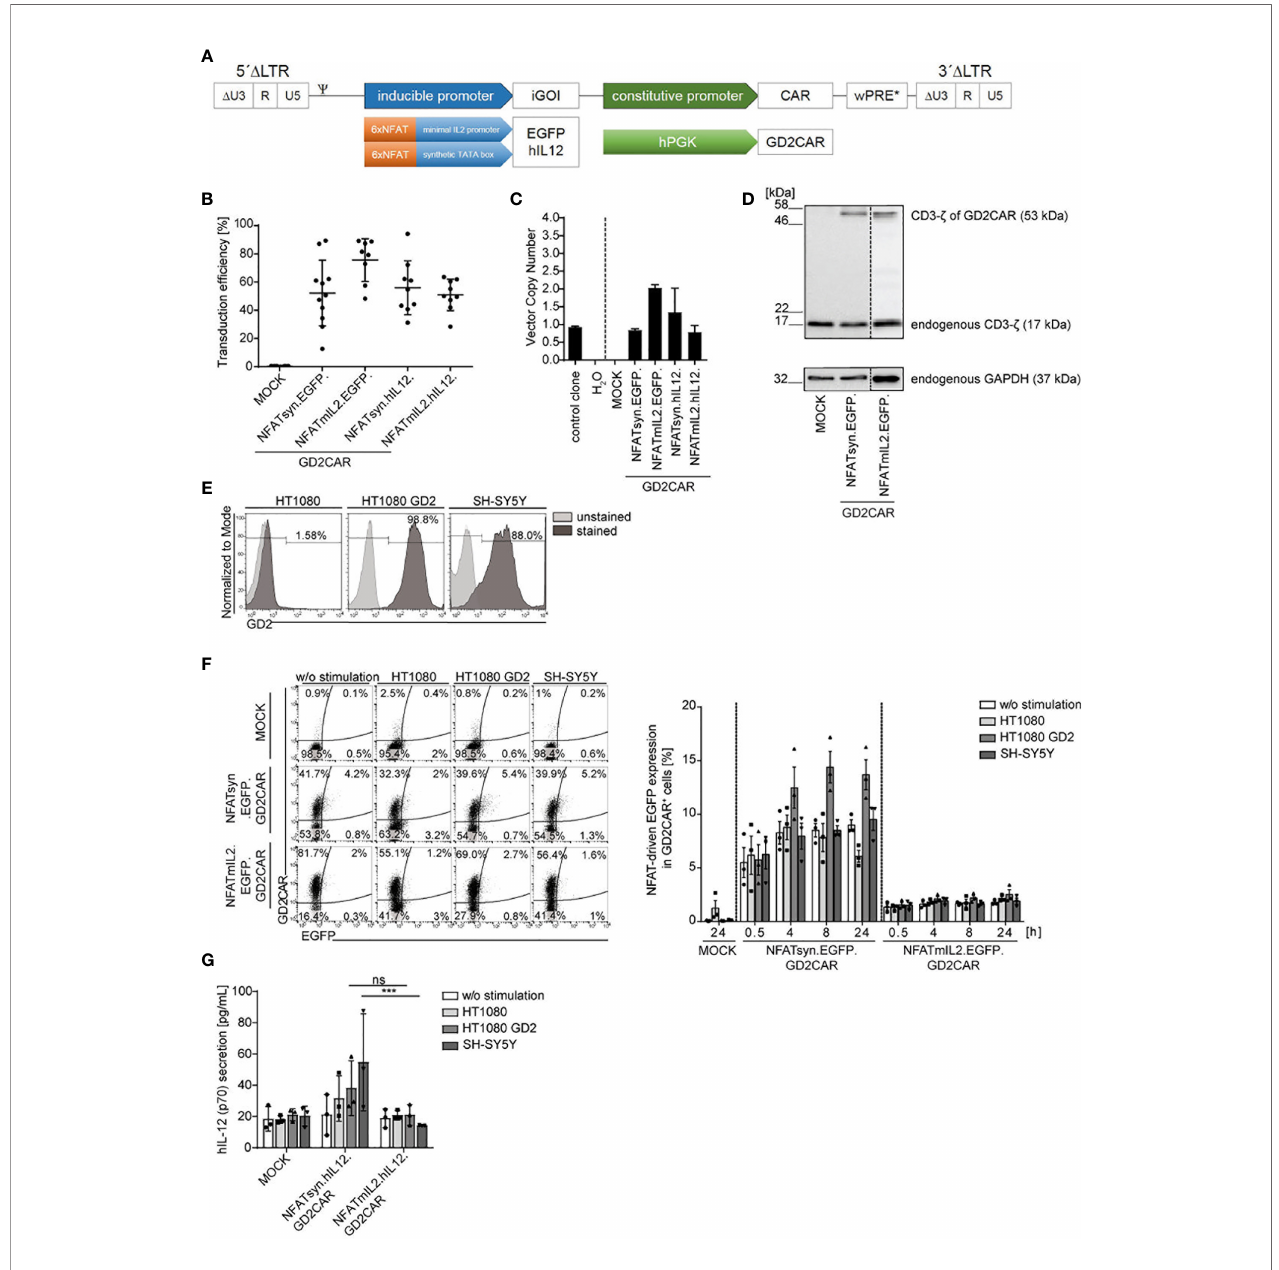
FIGURE 1 | Generation and validation of the alpharetroviral NFAT-driven “ all-in-one ” SIN vector constructs. (A) Scheme of the alpharetroviral self-inactivating “ all-in- one ” provirus constructs encoding for a constitutively expressed GD2CAR and an iGOI, namely, EGFP and hIL-12. The constitutive GD2CAR expression is driven by a human phosphoglycerate kinase (hPGK) promoter. The inducible gene cassette includes six consensus NFAT (6xNFAT) elements in combination with either a minimal IL2 promoter (NFATmIL2) or a synthetic TATA box (NFATsyn). (B) Transduction ef fi ciencies of NK-92 cells modi fi ed with the indicated alpharetroviral “ all-in-one ” SIN vector constructs and pseudotyped with RD114/TR (MOI 10). Transduction ef fi ciencies were quanti fi ed by fl ow cytometric analyses for GD2CAR expression (n = 8 – 11). (C) VCN determination of unsorted modi fi ed (MOI 10) NK-92 cells. As controls, the VCNs of a water sample and an induced pluripotent stem cell (iPSC) clone HD2 (47) with a known VCN of 1 were calculated. Technical triplicates are shown. (D) CAR protein expression in unsorted transduced (MOI 10) NK-92 cells exemplarily shown for NFATmIL2.EGFP and NFATsyn.EGFP constructs via Western blot analysis. The CD3- z domain of the GD2CAR (expected size approximately 53 kDa) and the endogenous CD3- z (17 kDa) as an internal control were detected. The housekeeping protein glyceraldehyde-3-phosphate-dehydrogenase (GAPDH, 37 kDa) served as a second control. (E) Flow cytometric analysis of GD2 expression on target cell lines used for functional testing via coculture experiments. (F) Representative fl ow cytometric analysis of inducible EGFP upregulation of unsorted modi fi ed (MOI 10) NK-92 cells after 24 h of coculture with indicated target cells at an effector to target ratio (E:T) of 10:1. The bar graph summarizes the inducible GD2CAR-speci fi c EGFP upregulation of modi fi ed NK-92 cells after coculture experiments (n = 3). (G) Inducible human IL-12 secretion of modi fi ed NK-92 cells after antigen recognition in 24-h coculture experiments at an E:T ratio of 10:1. Human IL-12 levels were determined by ELISA (n = 3). Indicated signi fi cance was determined by two-way analysis of variance (ANOVA) with Tukey´s multiple-comparison test; ***p ≤ 0.001. Mean values ± SD are shown. ns, not signi fi cant. Untransduced NK-92 cells were termed